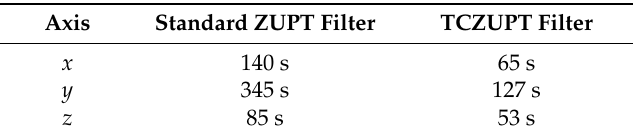
Table 12. Convergence time of the standard ZUPT and TCZUPT filter in case of residual error of 15